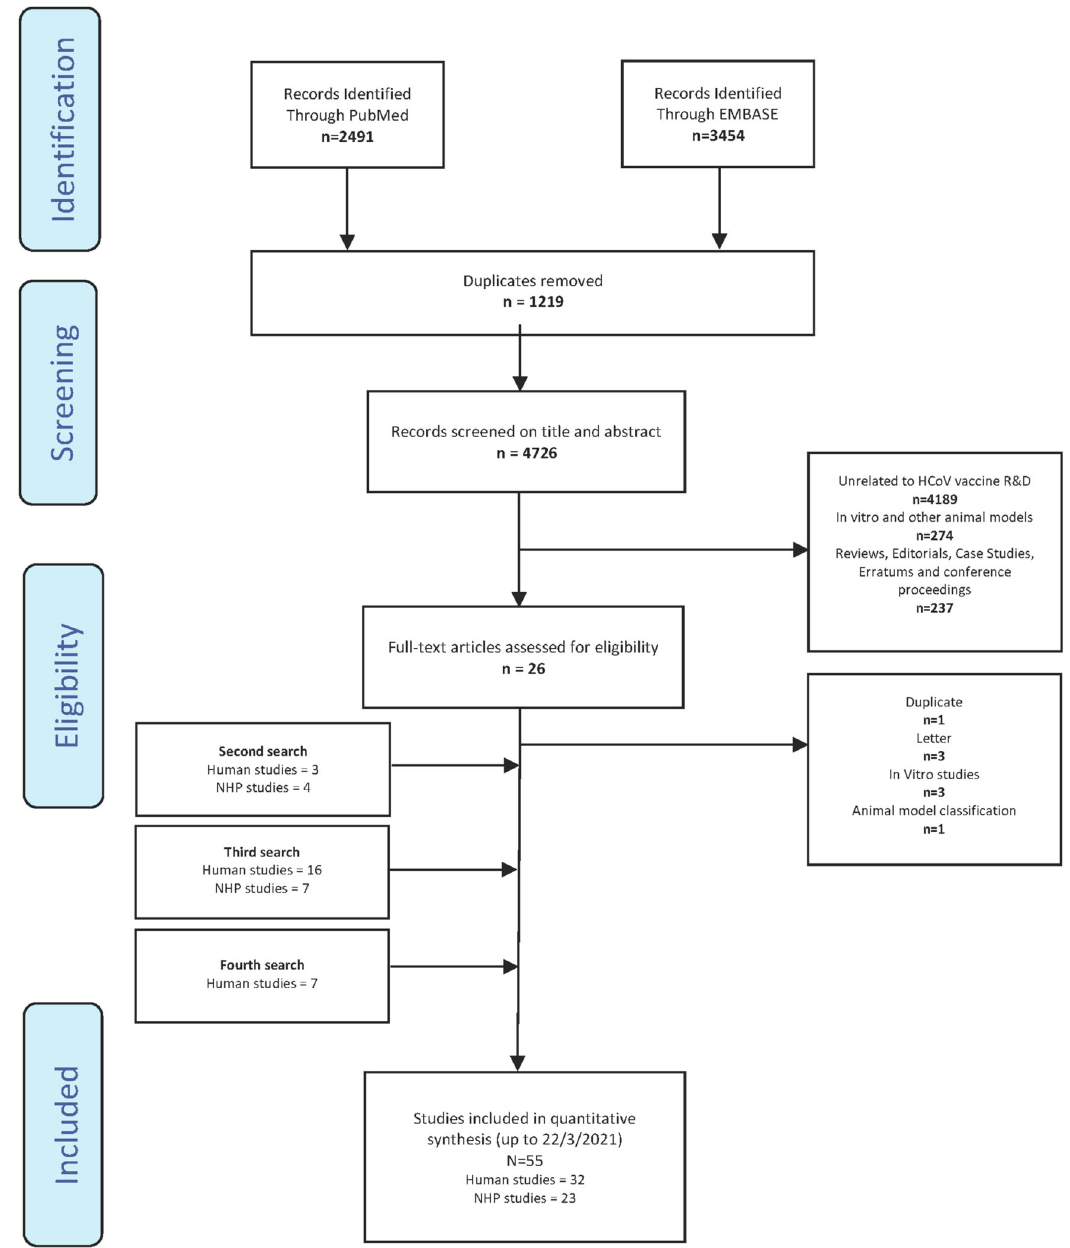
Supplementary Table 5. The greatest focus of research activity was in China and the USA (Supplementary Fig. 1). The mean age in human trials was 42.7 years. The gender distribution in human vaccine groups was roughly equal. Vaccine group ethnicity was skewed as follows: 72.8% of participants were White,